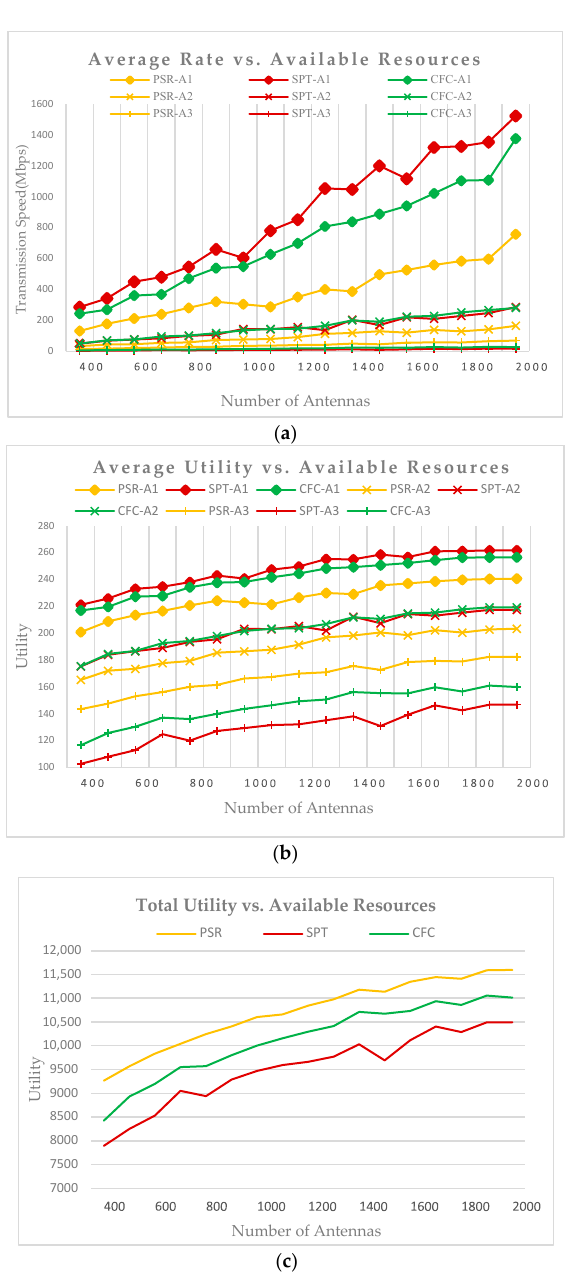
Figure 5. Performance of each area under different antennas: ( a ) data rate, (b) utility, ( c ) total utility.